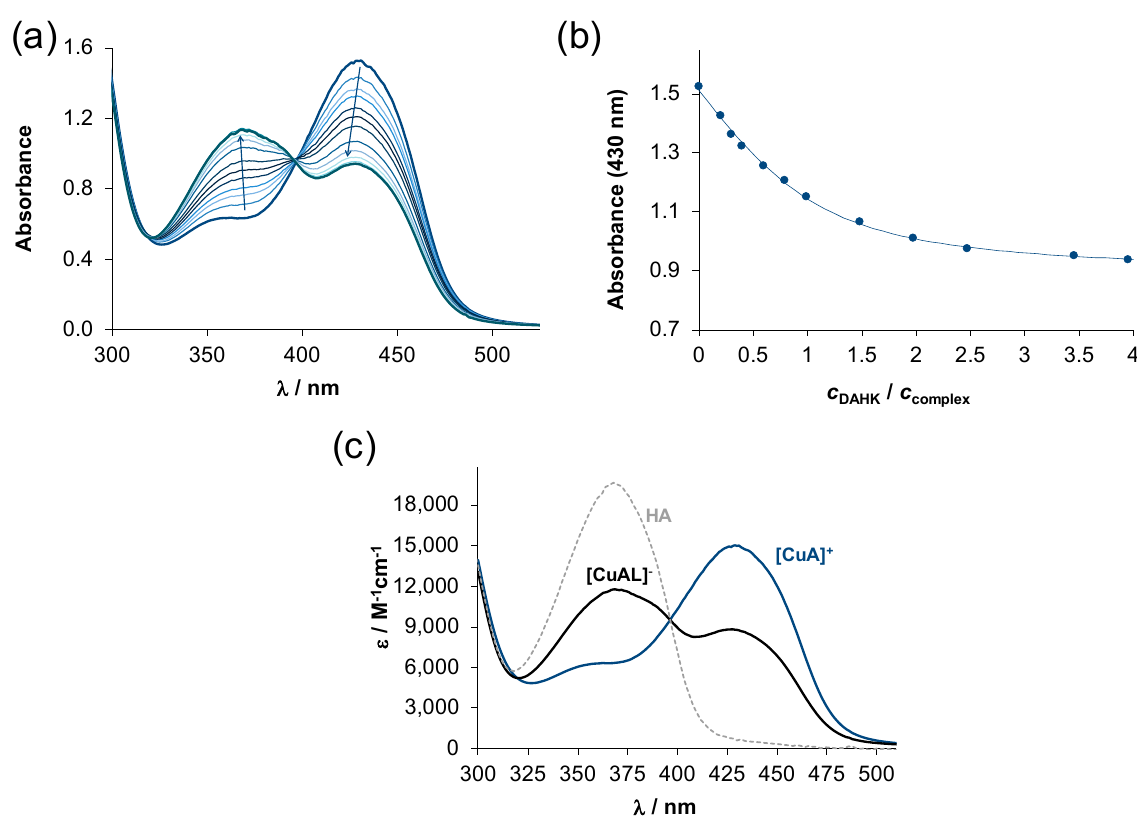
Figure 2. ( a ) UV–vis spectra recorded for the copper(II) ‒ Triapine ‒ DAHK (1:1:x) system at pH 7.4 after 4 h equilibration time (x:0–4). ( b ) Absorbance values at 430 nm plotted against the ratio of DAHK and the copper(II)-Triapine complex. ( c ) Molar absorbance spectra of the Triapine complex ([CuA] + ), the Triapine-DAHK ternary complex ([CuAL] − ), and the unbound Triapine molecule (HA). { c Cu(II) = c Triapine = 200 μM, c DAHK = 0‒800 μM; 30% ( w / w ) DMSO/H 2 O; pH = 7.4 (20 mM HEPES); T = 25 °C; I = 0.10 M (KCl); ℓ = 0. 5 c m}. Table 2. Anisotropic EPR parameters calculated for the various species formed in the binary copper(II) ‒ Triapine/STSC/DAHK and ternary copper(II) ‒ Triapine/STSC (A) ‒ DAHK (L)/HSA systems in 30% ( w / w ) DMSO/H 2 O at